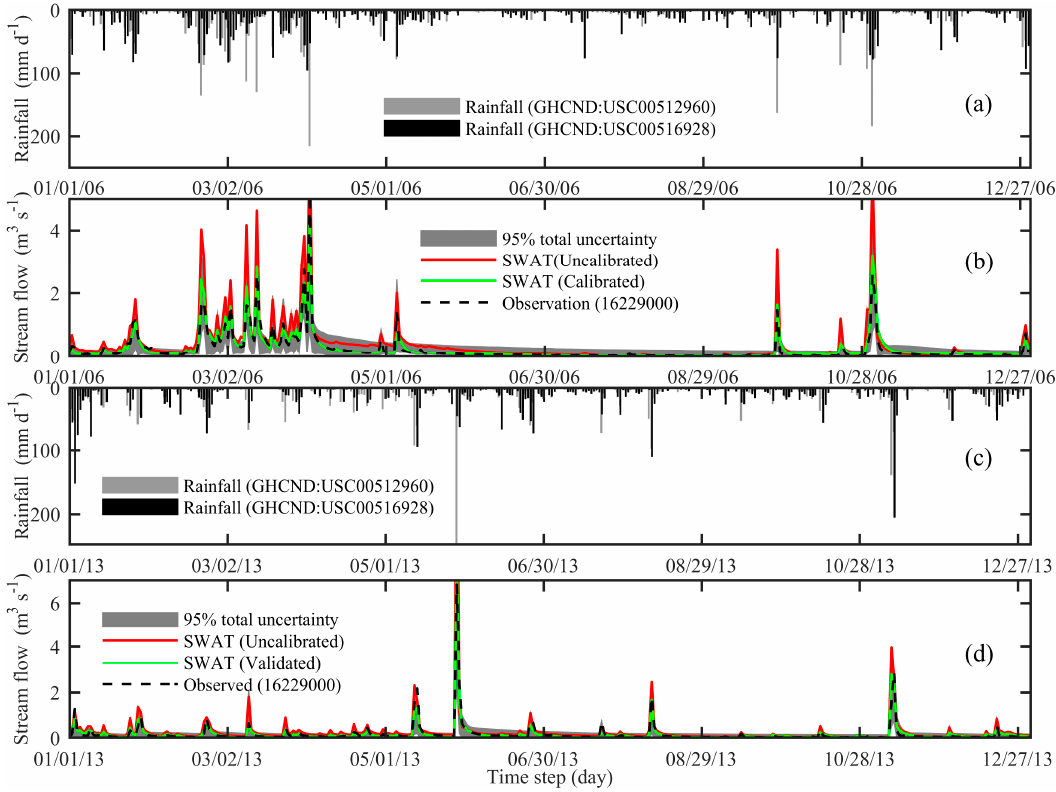
Figure 4. ( a ) Daily gauge rainfall of 2006 and ( b ) the respective simulated and observed streamflows at USGS gauging #16229000 (calibration period); and ( c ) daily gauge rainfall of 2013 and ( d ) the respective simulated and observed streamflows (validation period) for the Kalihi